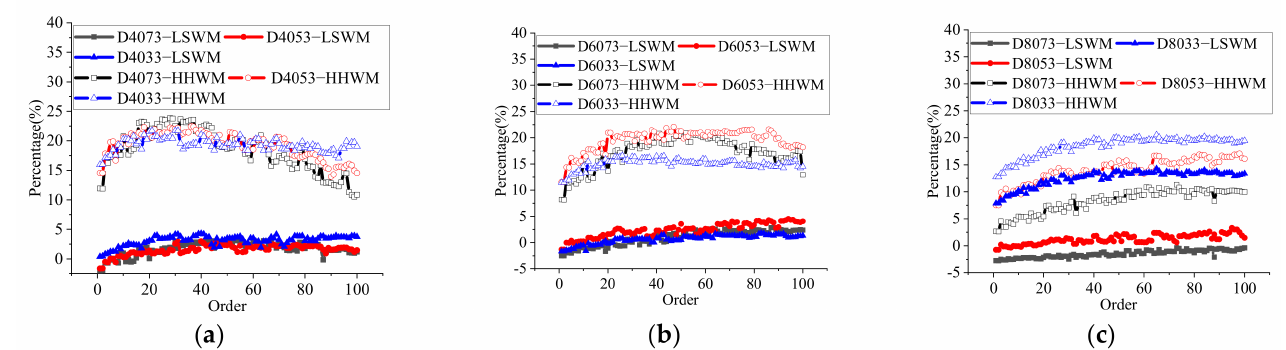
Figure 5. The comparison of the frequencies of the shell with various roofing systems: ( a ) 40 m; ( b ) 60 m; ( c ) 80 m.